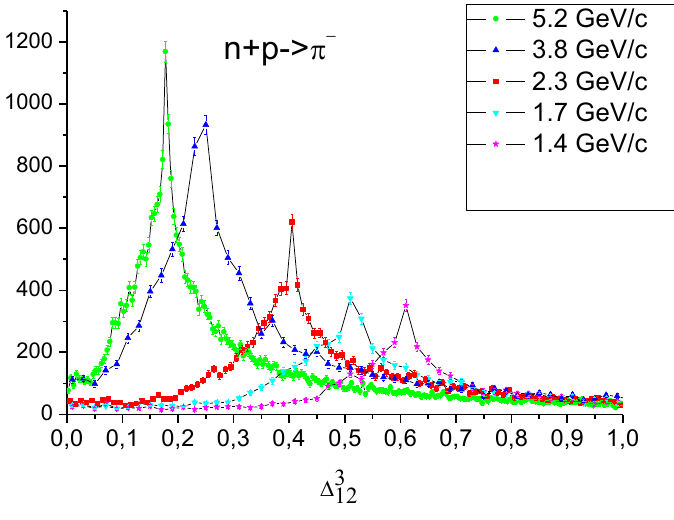
3  for the experimental data obtained 12